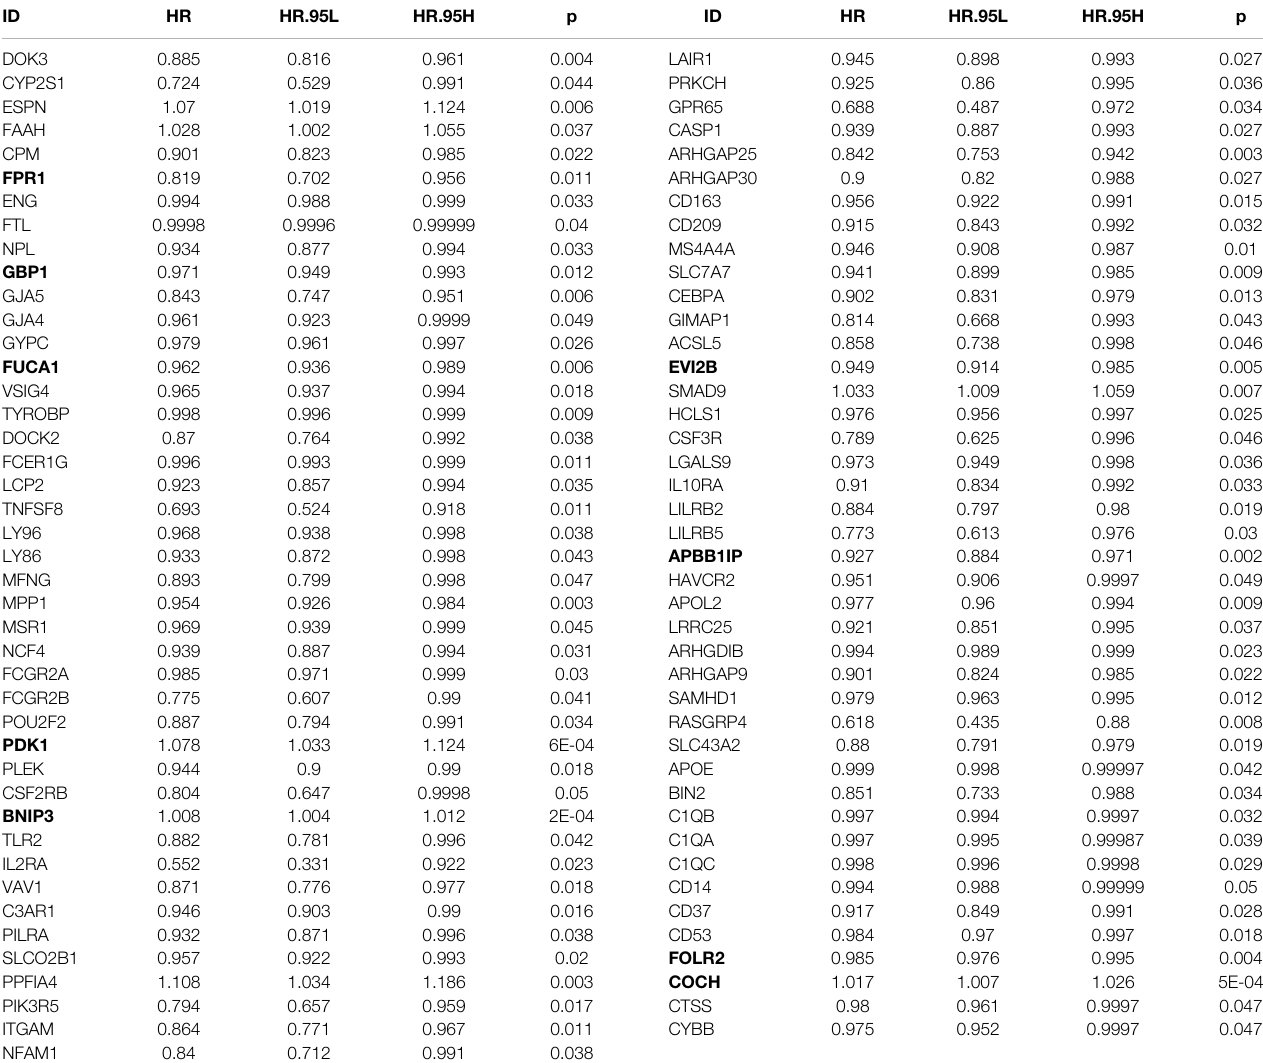
TABLE 1 | Univariate Cox regression analysis for prognosis-related stromal-immune score-based genes in osteosarcoma. The bold value represent the signature-related genes. ID